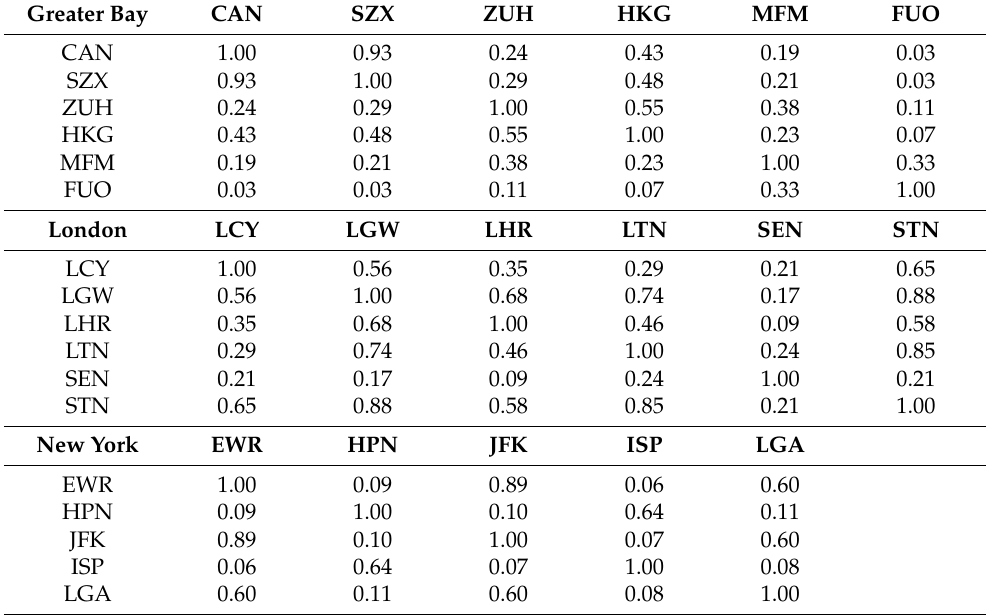
Table A2. Homogenization result of